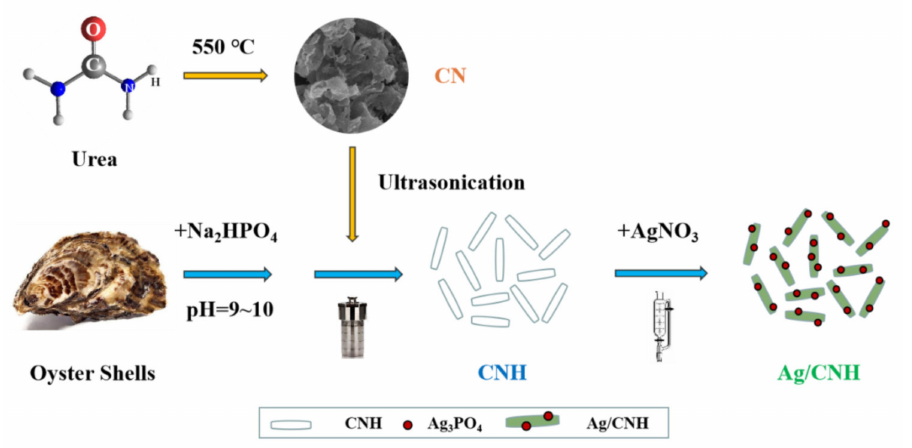
Figure 11. Synthesis process of Ag/CNH